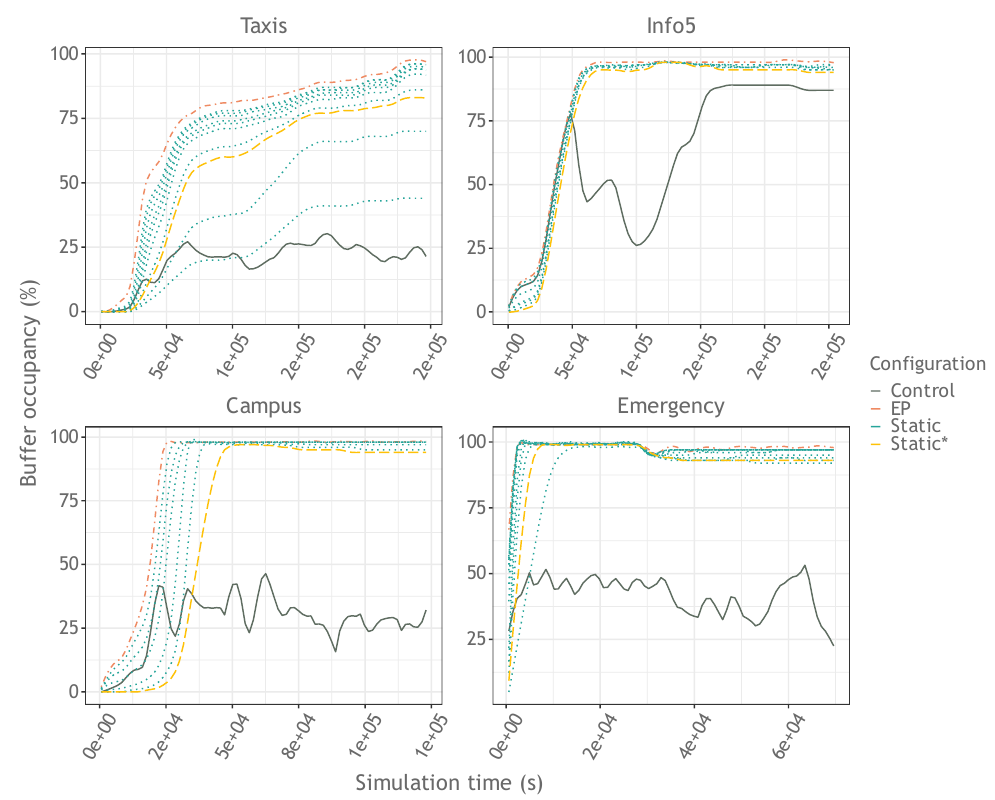
Figure 7. Percentage of the buffer occupancy for the different policies, for each scenario, along the simulation time. In the legend, the configuration named Static* corresponds to the Static configuration with the replication limit that the Control tends